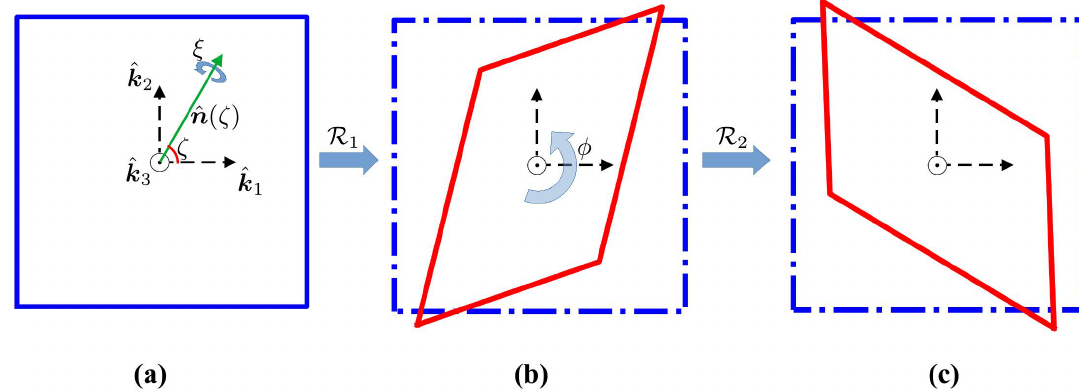
Figure A1. Sequence of transformations that parameterize the effective detector tilts in this paper. In each sub-figure, the plane of the figure is the imaging plane, with the orthonormal basis B img shown. ˆ k 3 exits the plane of the figure. The blue outline delineates the projected area of the un-tilted detector when viewed from this vantage point, while the red area delineates the projected area of the tilted detector. ( a ) The initially un-tilted detector. ( b ) The projected detector area (outlined in red) after the transformation R 1 , which rotates it by an angle ξ , about the imaging-plane axis ˆ n ( ζ ) ≡ [ cos ζ sin ζ 0 ] T . ( c ) The (final) projected area of the tilted detector after the subsequent rotation R 2 by an angle φ about ˆ k = 60 ◦ , ζ = 60 ◦ , φ = 73 ◦ (i.e., the penultimate row 3 . The specific case shown here corresponds to ξ in Table